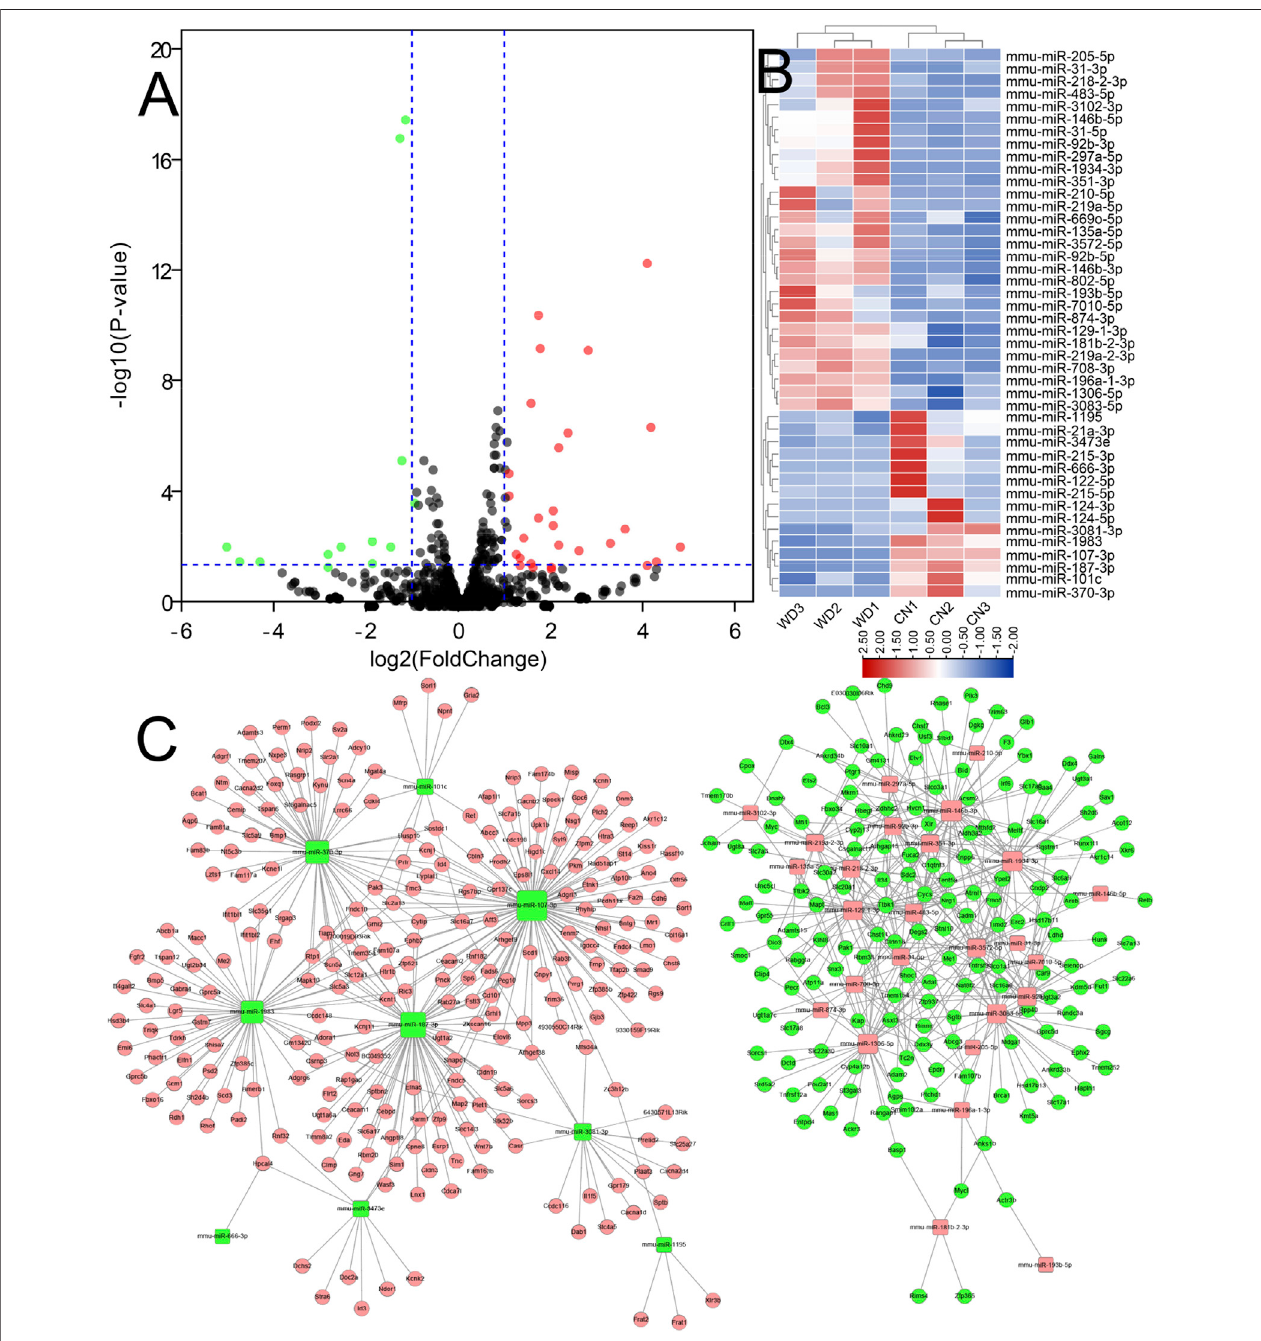
FIGURE 4 | DEmiRs between WD and control groups. (A) DEmiRs displayed on a volcano plot. Blue and red indicate > two folds of decrease and increase in expression, respectively ( p < 0.05). Gray indicates no signi fi cant difference. (B) DEmiRs displayed via hierarchical clustering; numbers indicate the samples used for sRNA-seq. (C) The miRNA-mRNA network constructed using DEmiRs and DEPs that were identi fi ed using sRNA-seq and RNA-seq. Pink nodes indicate upregulated RNAs and green nodes downregulated RNAs. Square nodes represent miRNAs. Circular nodes represent protein-coding genes.